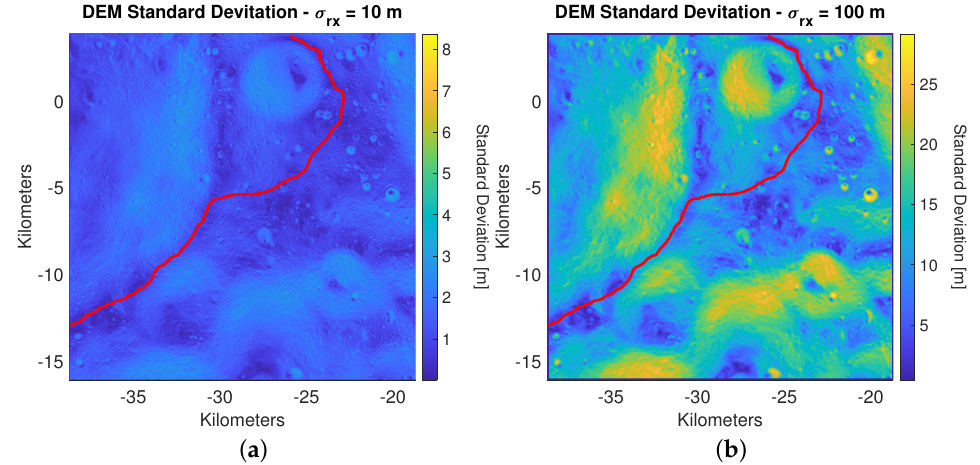
Figure 8. Standard deviation ( σ rx ) of the lunar terrain surrounding the rover traverse (in red). ( a ) shows the standard deviation of the terrain height considering all pixels which have their centre within 10 m of the query point, while ( b ) shows the standard deviation for all pixels which have their centre within 100 m of the query point. The projection is polar stereographic, where (0, 0) denotes the South Pole.